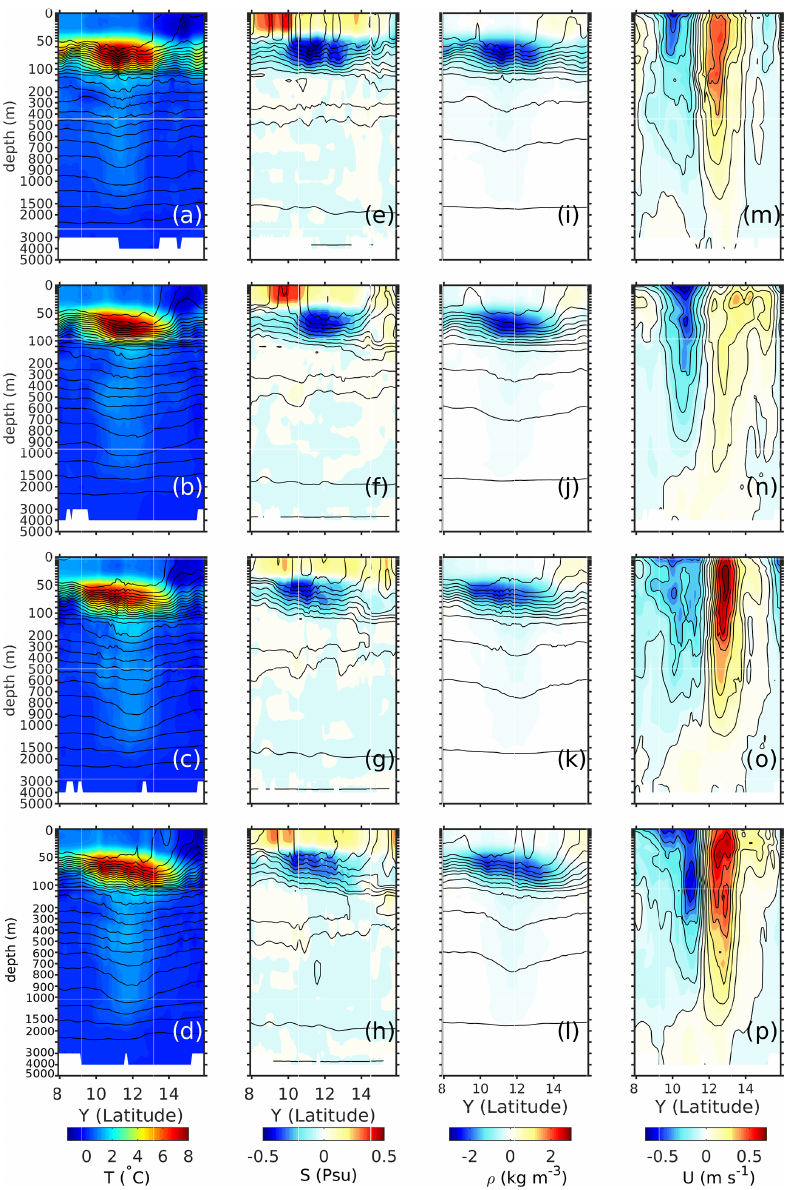
Figure 11. Vertical sections of ( a to d ) temperature, ( e to h ) salinity, ( i to l ) density, and ( m to p ) zonal velocity at 3 April, 27 April, 11 May, and 16 May 2019 (solid black lines) and their anomalies with respect to climatological mean values of 2018 (color shading). The solid lines in temperature field range between 2 and 27 ◦ C in 1 ◦ C intervals. The solid lines in salinity field range between 33 and 34.8 with 0.2psu intervals. The solid lines in density fields range between 1021 and 1027kgm − 3 in 0.5kgm − 3 intervals, and the current field anomalies range between 0.7 and 0.7ms − 1 in 0.05ms − 1 velocity